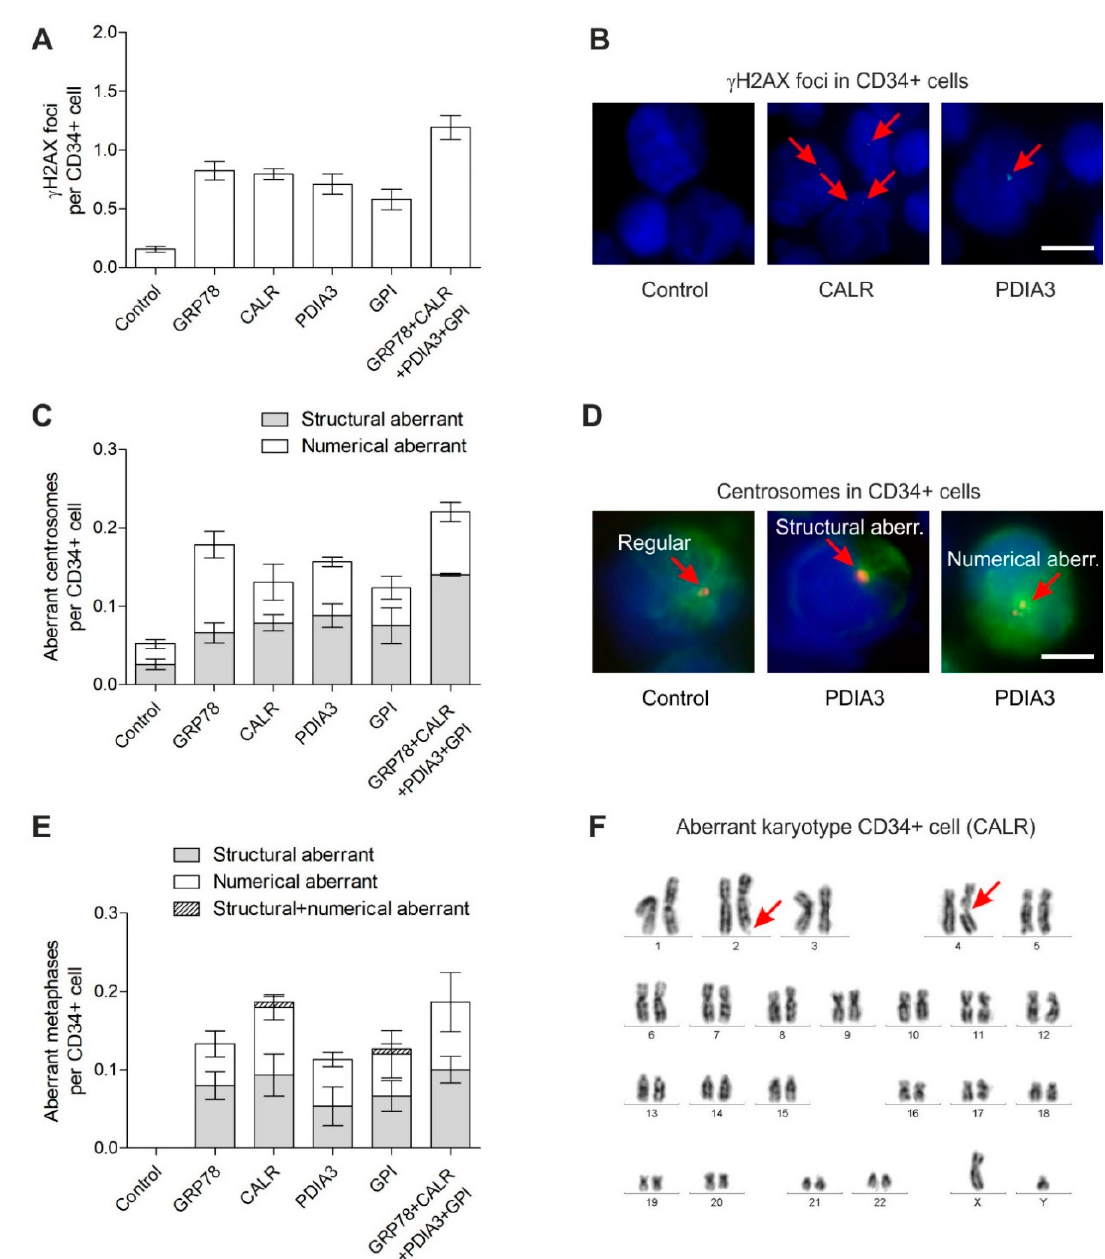
Figure 1. Genetic instability in CD34+ cells grown for 3 days in medium supplemented with recombinant GRP78, CALR, PDIA3 and GPI. ( A ) γ H2AX foci levels in CD34+ cells ( n = 4 patients); Poisson regression: p = 0.0344; Dunnett’s test each p < 0.0001). ( B ) Exemplary immunofluorescence images of γ H2AX foci (green, Alexa 488) in nuclei (blue, DAPI) of CD34+ cells. Scale bar, 7.5 µ m. ( C ) Numbers of aberrant centrosomes per CD34+ cell ( n = 3 patients); Kruskal–Wallis test: p = 0.0249; Wilcoxon two-sample test: each p = 0.1000). ( D ) Exemplary immunofluorescence images of regular, structural aberrant and numerical aberrant centrosomes (orange, Alexa 555) and microtubules (green, Alexa 488) in nuclei (blue, DAPI) of CD34+ cells. Scale bar, 5 µ m. ( E ) Numbers of aberrant metaphases